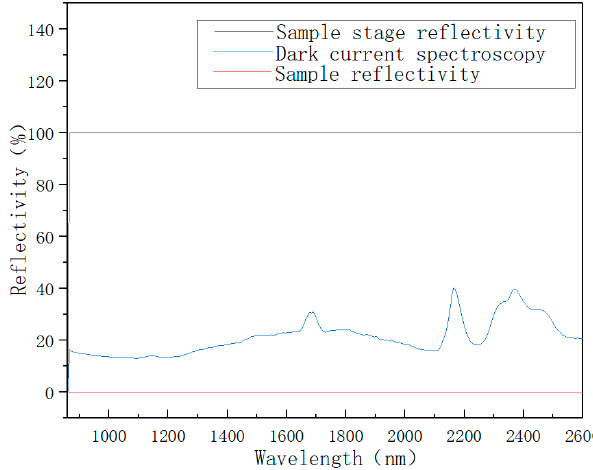
Figure 3. Instrument debugging before sample collection.